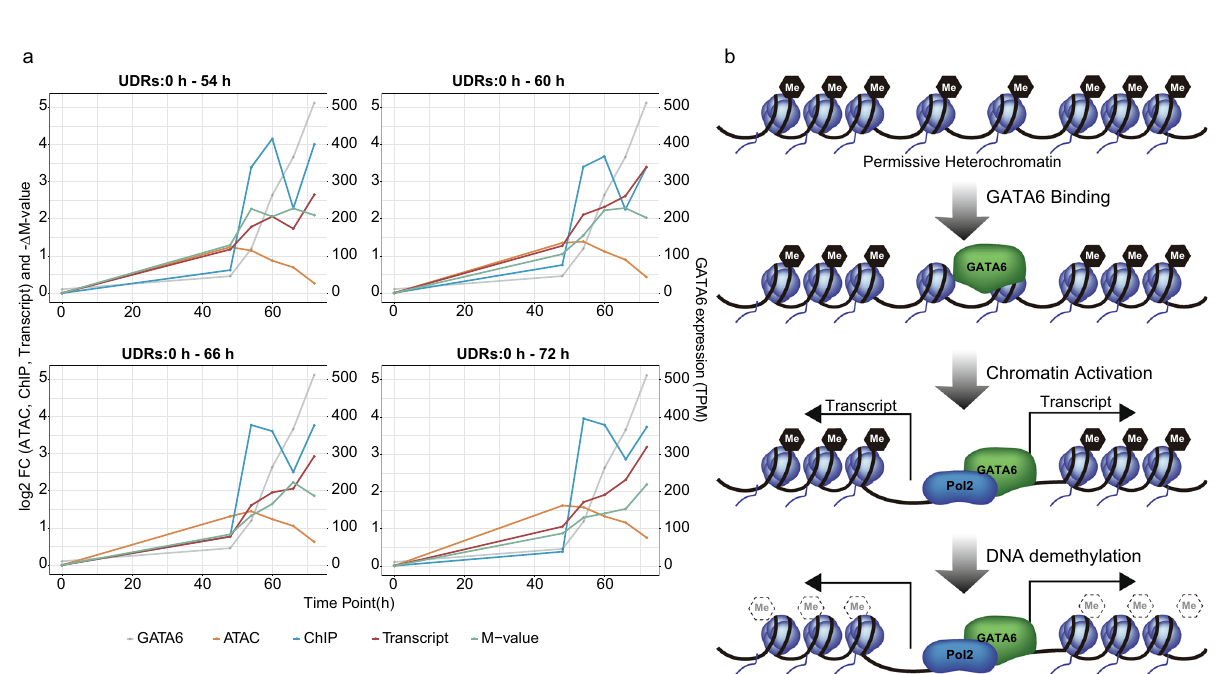
Fig. 6 Multi-omics kinetic analysis. a Line plots showing changes in each demethylated region ’ s omics data. Y-axis is log 2 fold-change (FC) for read coverages of ATAC-seq and ChIPmentation for GATA6 (left scale), and - Δ M-value (left scale); TPM for GATA6 expression (right scale). X-axis represents the time points of the differentiation. CAGE-based GATA6 expression pro fi les are identical among the panels. b A schematic illustration showing a model of interrelation between GATA6-mediated DNA demethylation and chromatin